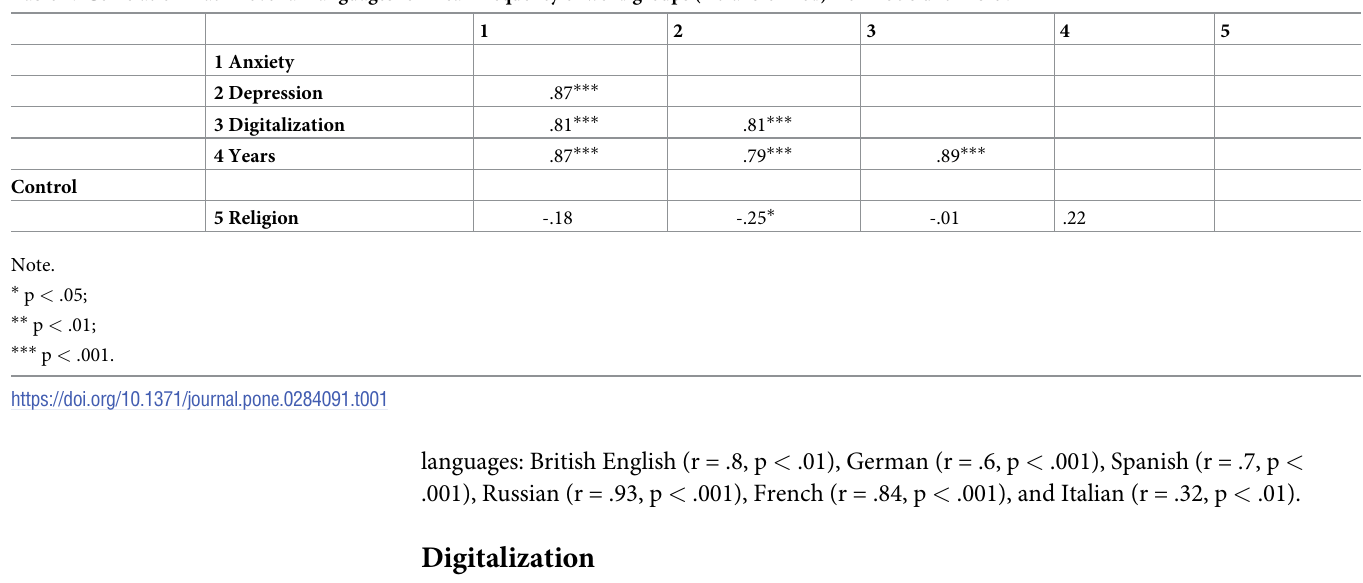
Table 1. Correlation matrix over all languages for mean frequency of word groups (z-transformed) from 1970 until